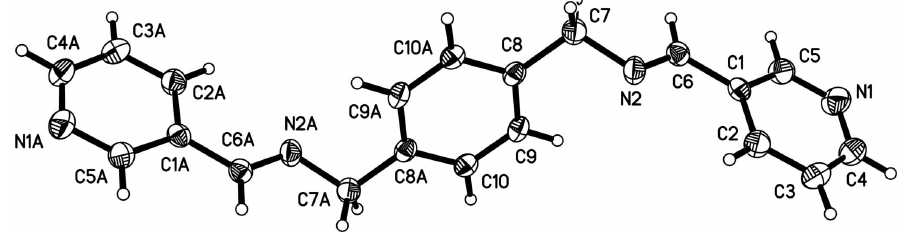
The molecular structure of the title compound (thermal ellipsoids are shown at 30% probability